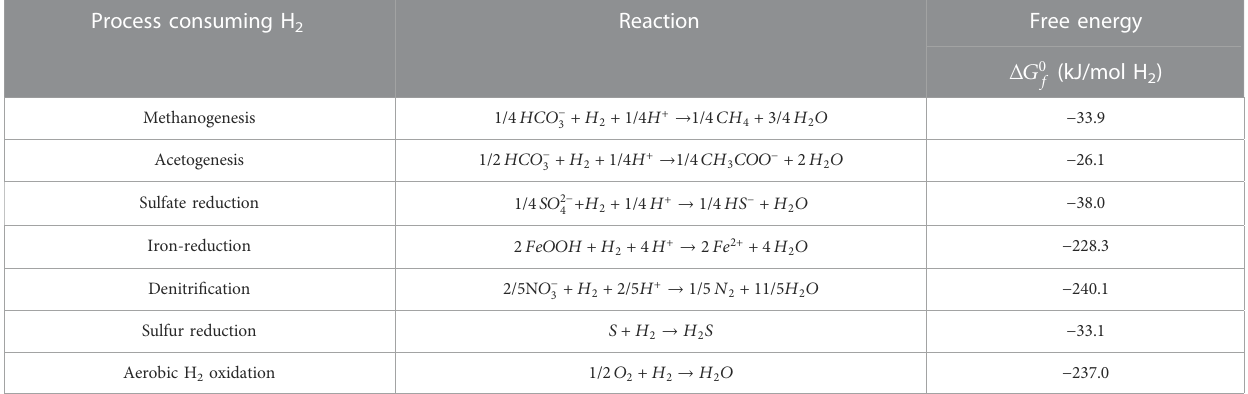
TABLE 1 Redox reactions involving oxidation of hydrogen relevant for underground hydrogen storage in sandstone